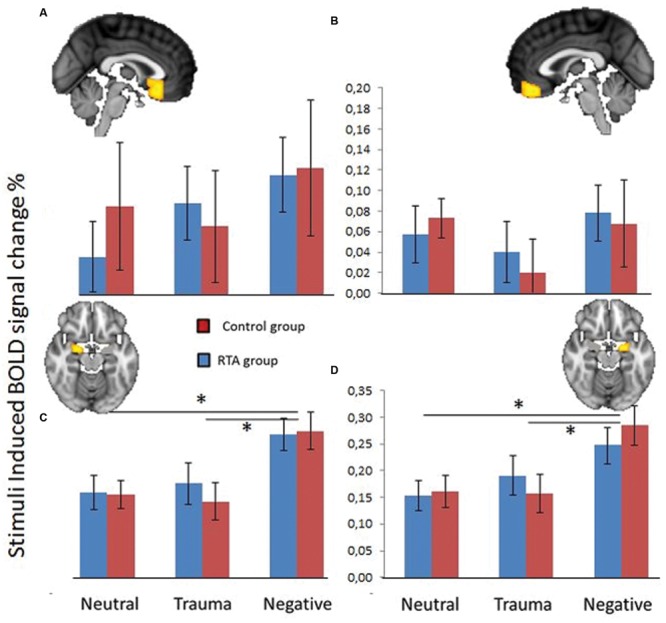
Blood oxygen level dependent (BOLD) signal change (%) in subcallosal cortex (A), fronto medial cortex (B), left amygdala (C), and right amygdala (D), over three stimuli conditions; Neutral, Trauma-specific, Negative. Blue equals Trauma group (RTA), and red equals HCs. Error bars represent 1 standard error of the mean. *p < 0.05.